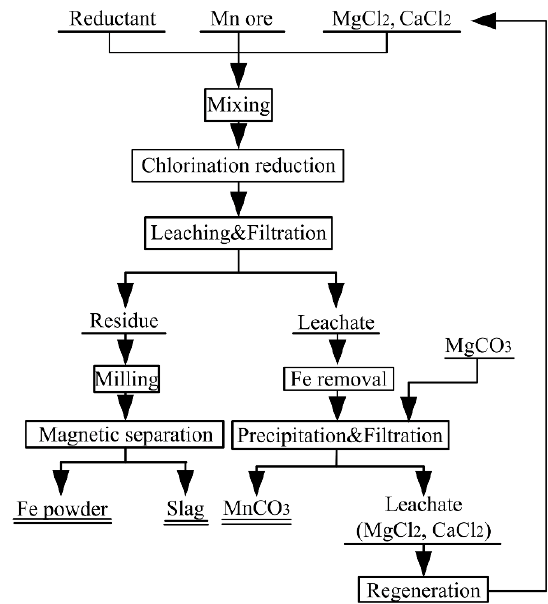
Figure 18. Proposed flow sheet for the selective chlorination and carbothermic reduction of high-Fe manganese ore.